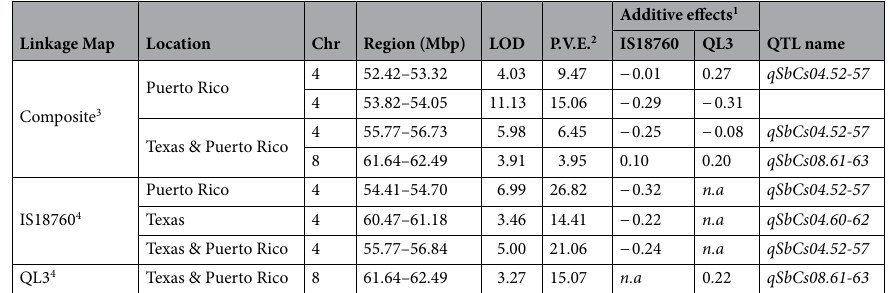
Table 3. Genomic regions associated with the anthracnose resistance response revealed by the QTL analysis of two sets of recombinant inbred lines derived from the crosses between QL3 and IS18760 with a common parental line PI609251 evaluated at Puerto Rico and Texas in 2016, 2017 and 2018. 1 Negative sign indicates the resistant allele is derived from resistant parent (IS18760 or QL3). 2 Percent of variance explained by the QTL. 3 LOD values based on joint inclusive composite interval mapping as implemented in QTL IciMapping using a 982 SNPs composite linkage map. 4 LOD values based on inclusive composite interval mapping as implemented in QTL IciMapping using 982 SNPs linkage map from each recombinant inbred line